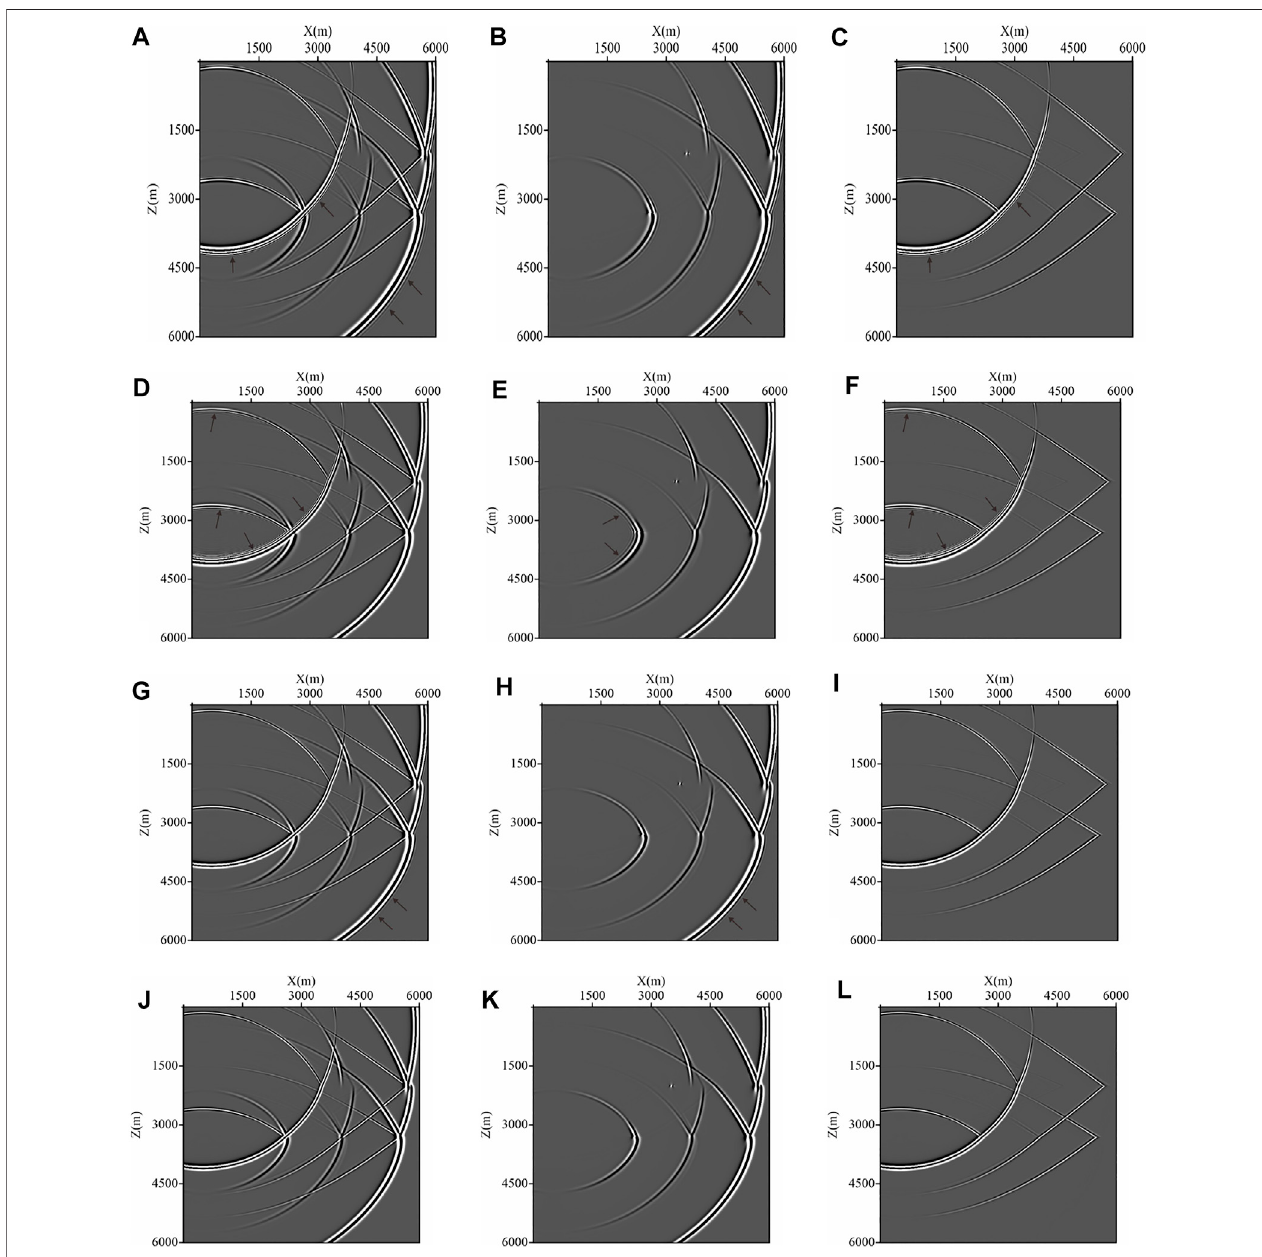
FIGURE9 | Elasticsnapshots of υ x and decomposed P- and S-wave components at 2.4 sfor the three-layered model simulatedwithtime step Δ t (cid:2) 1 . 5ms. (A – C) C-SFD( M =10), (D – F), and (G – I) M-SFD( M =8; N =1)withtheFDcoef fi cientscalculatedbasedontheP-andS-wavetime-spacedomaindispersionrelation,respectively. (J – L) M-SFD ( M =8; N =1), solving the decomposed P- and S-wave equations.